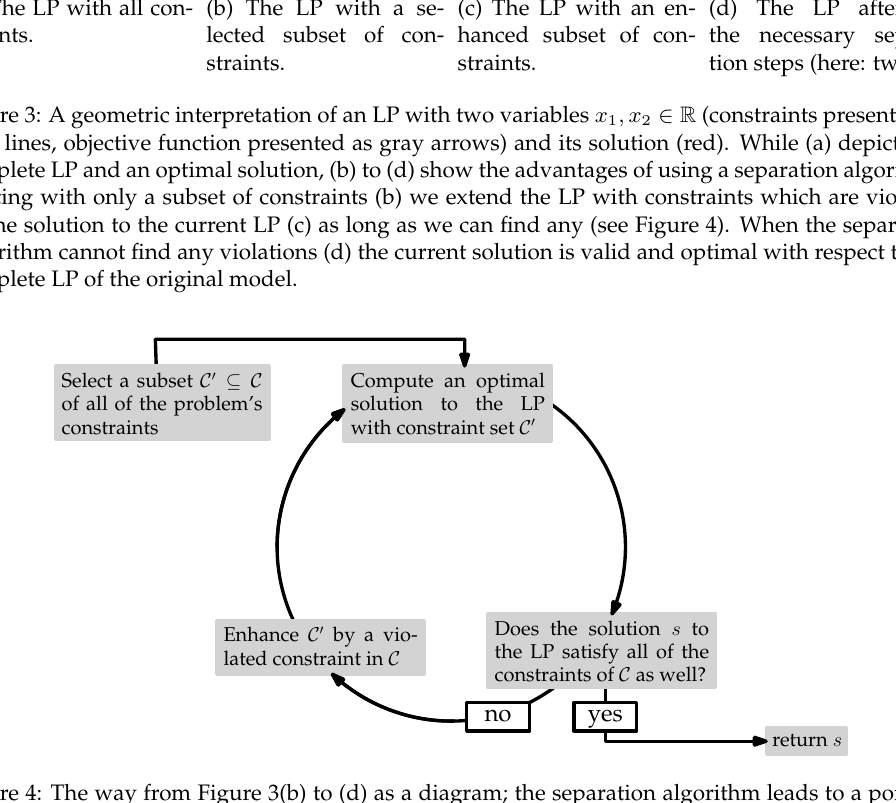
Figure 4: The way from Figure 3(b) to (d) as a diagram; the separation algorithm leads to a point of diversion depending on whether a violated constraint